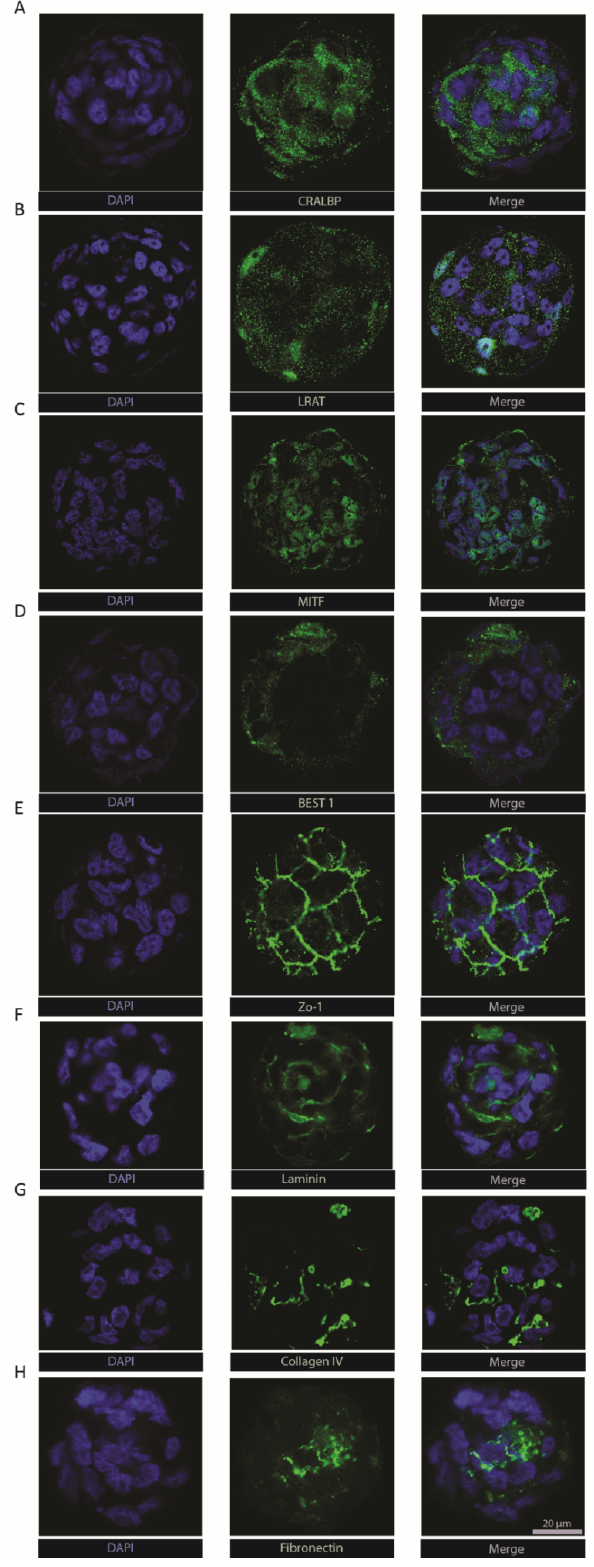
Figure 3. Engineered RPE- µ Ts maintain the expression of hallmark identity and functional RPE markers. Immunostained ARPE-19 RPE- µ Ts with antibodies against ( A ) CRALBP, ( B ) LRAT, ( C ) MITF, ( D ) BEST1, ( E ) ZO-1, ( F ) laminin, ( G ) collagen IV and ( H ) fibronectin. All samples were counter- stained with DAPI and are shown at the same magnification; scale bar = 20 µ